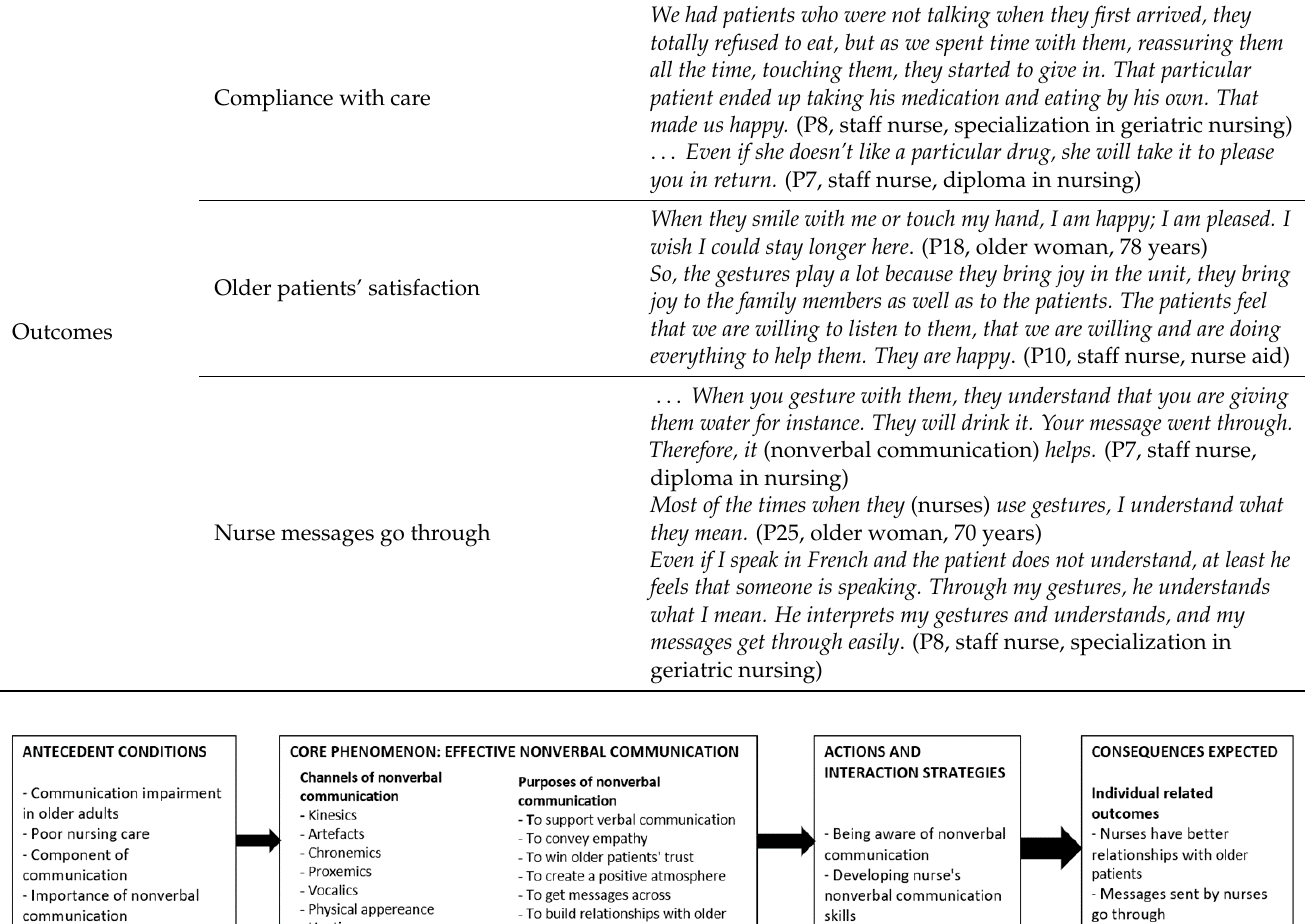
Table 4. Extracts of the outcomes forming the basis for developing the model.